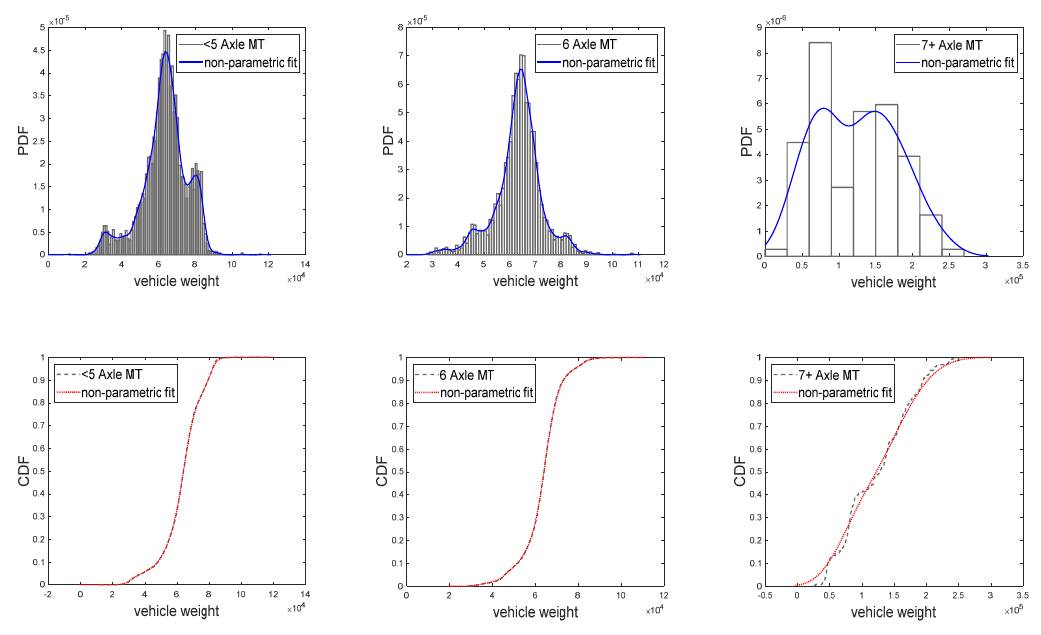
Figure 2. Weight of heavy vehicles.